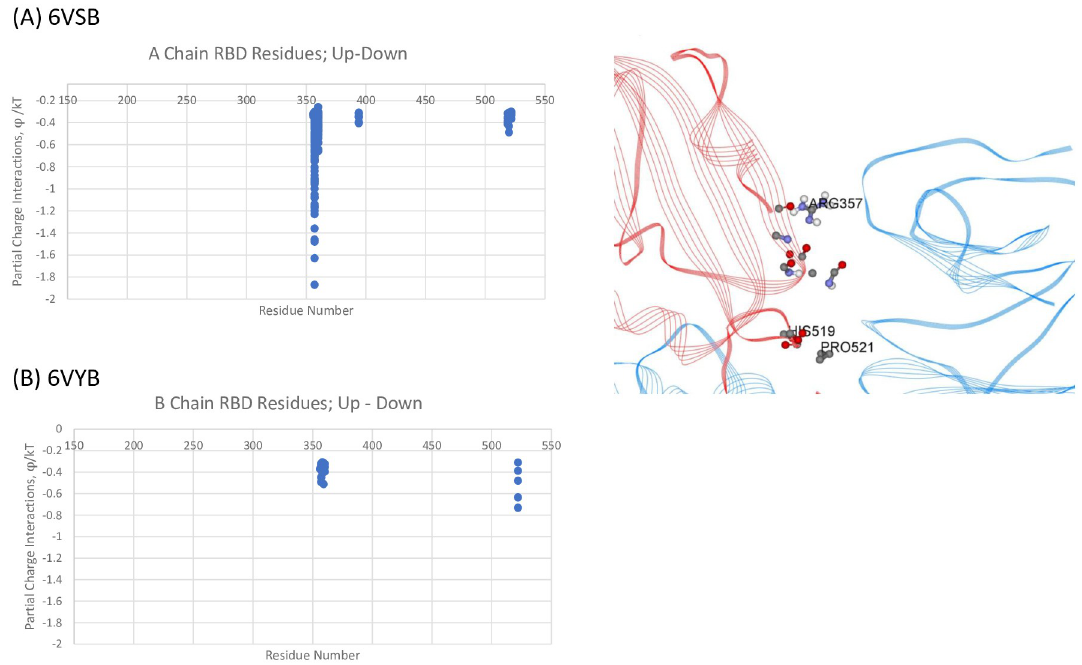
Fig 3. (A) Dominant Energy Landscape for the Interaction of the RBD Chain A (Up;red) with NTD Chain B (Down;blue) for 6VSB; oblique, top view. Only A Chain RBD residue/atoms are shown. (B) Mappings for Up-Down 6YVB. See S1–S10 Tables in S1 File for all data.